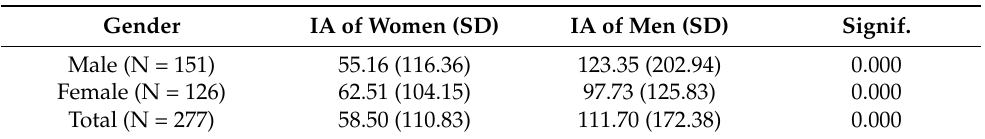
Table 6. Mean internal amplification of women and men, standard deviation, and significance by gender of the retweeter.